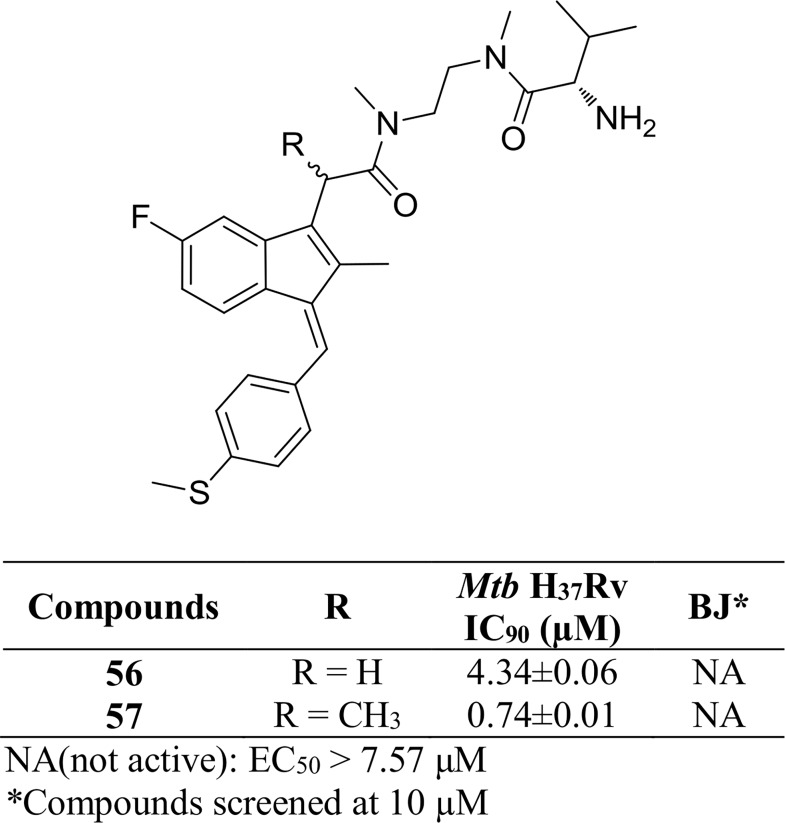
Mtb H37Rv and BJ cell data of extended Sulindac sulfide amide derivatives 56–57.